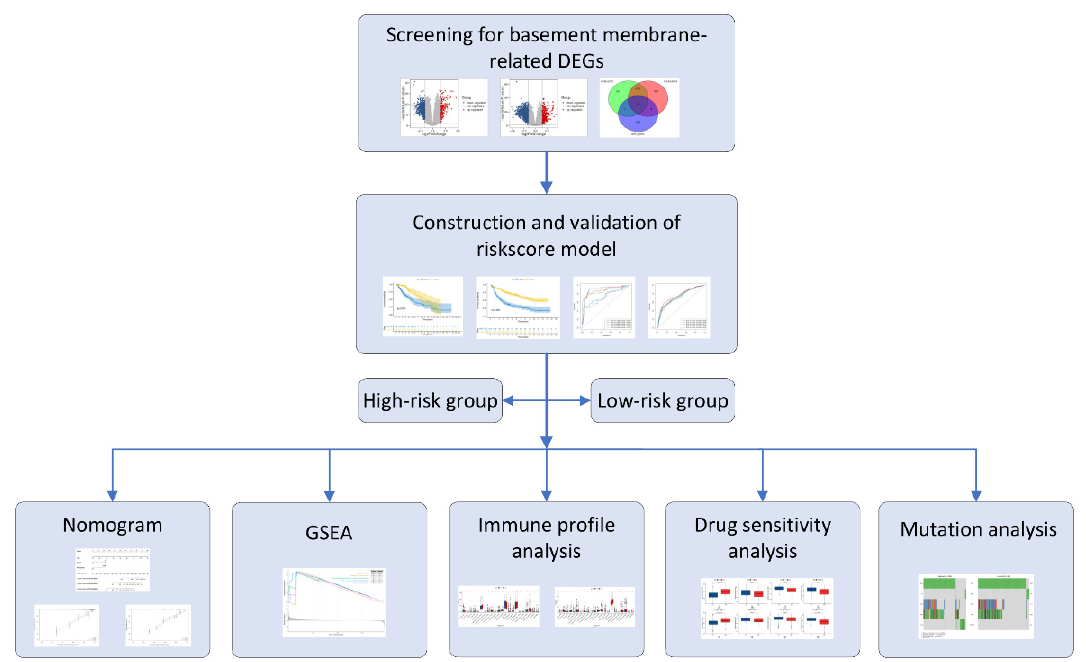
Figure 1. Workflow of the BM-related gene signature construction.